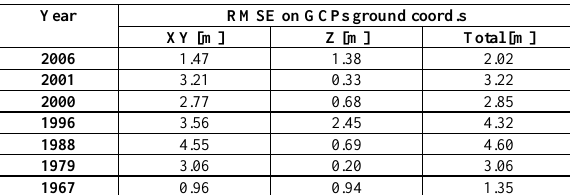
Figure 5 . The location and distribution of ground control points (GCPs) are shown by an example of a 3D dense cloud reconstruction from the 2001 data set.